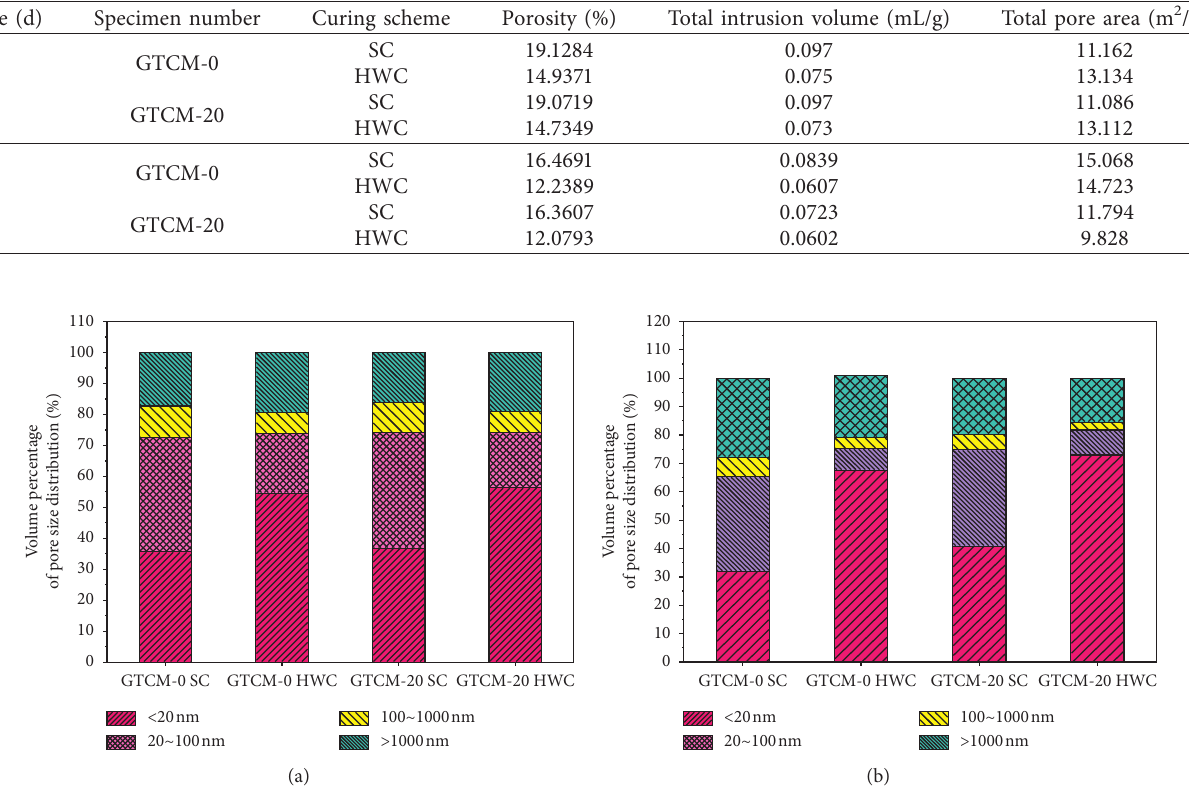
Figure 12: Pore volume percentage of GTCM-0 and GTCM-20 under SC and HWC methods: (a) 1 day and (b) 3